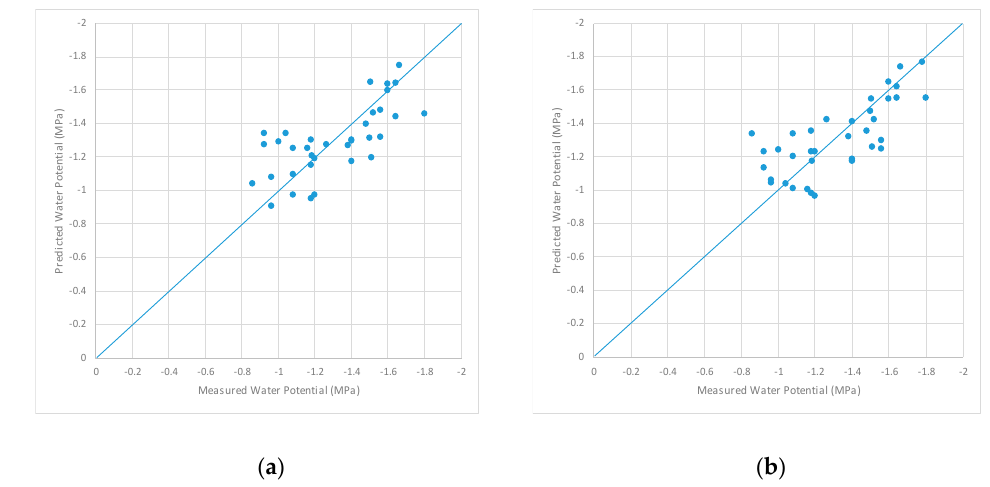
Figure 10. PLSR water potential prediction versus reference data in ( a ) a band 410 nm wide centred on 1265 nm (Zone I) for raw spectral data and ( b ) a band 1432 nm wide centred on 1552 nm (Zone IV) after applying Savitzky–Golay second-order derivative pre-processing. Data in ( a ) were fit to R 2 = 0.51 and an RMSE of 0.20, while data in ( b ) were fit to R 2 = 0.54 and an RMSE of 0.18.